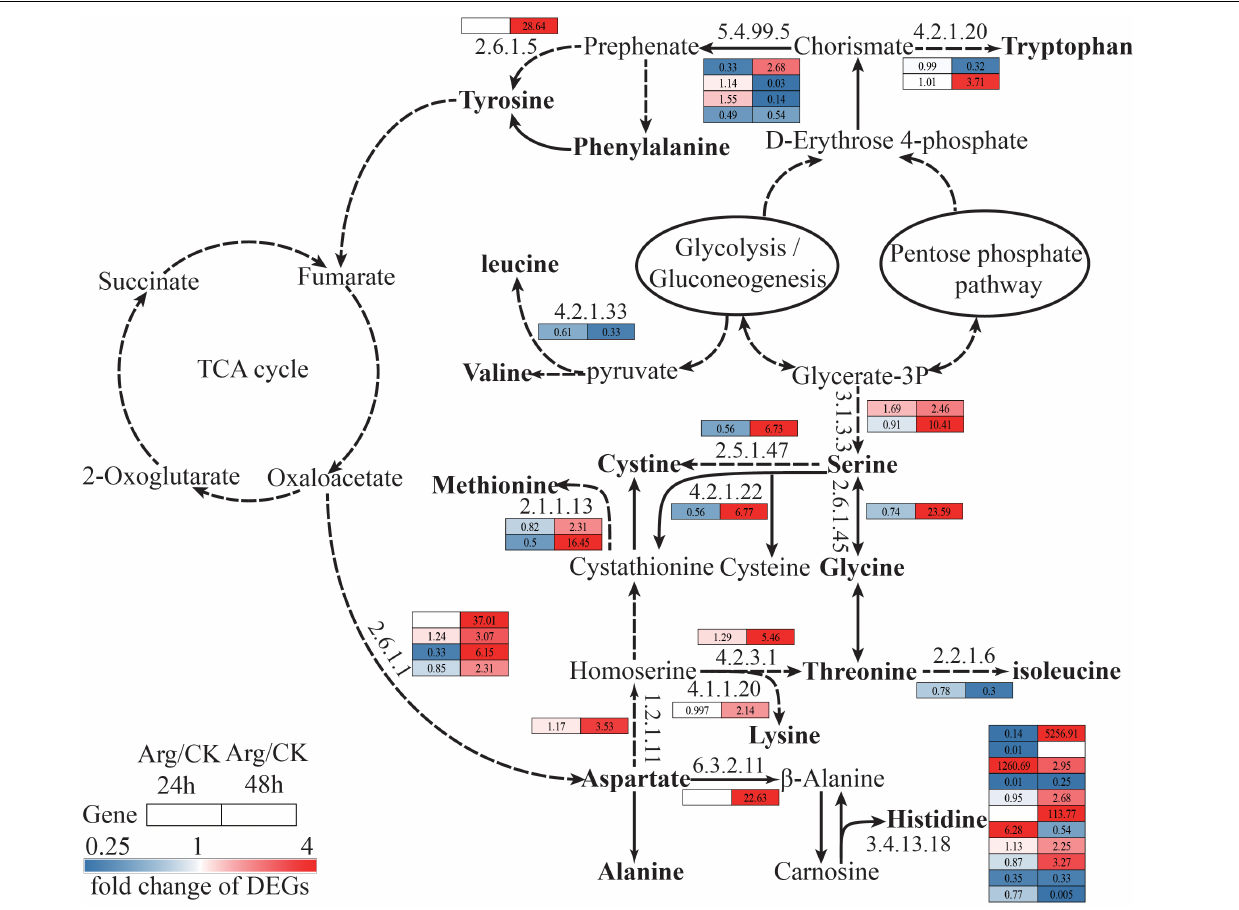
FIGURE 6 | Overview of amino acids biosynthesis and free amino acids content. The number and color in square represent the transcriptome information of DEGs at 24 h and 48 h, red and blue represent content increase and decrease, separately. The solid arrow indicates one-step reaction, the dotted arrow indicates poly-step reaction, and omitted intermediate steps. The same row represents the abundance change of one unigene at 24 h (left column) and 48 h (right column), the number in each square beside the enzyme code refers to the fold change of corresponding DEGs. Red, blue, and white squares indicate upregulation, downregulation, and not expressed, separately. DEGs, differentially expressed